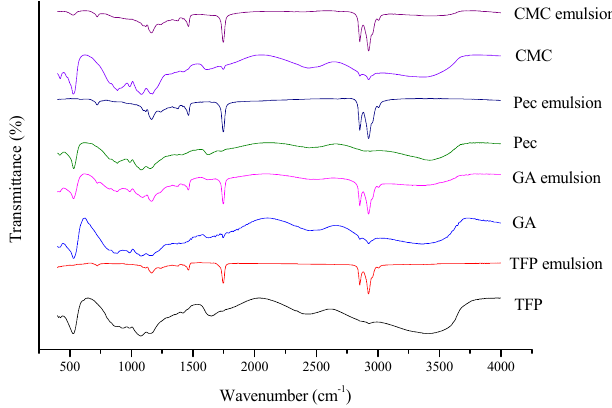
Figure 9. FTIR of TFP, GA, Pec, and CMC and its corresponding